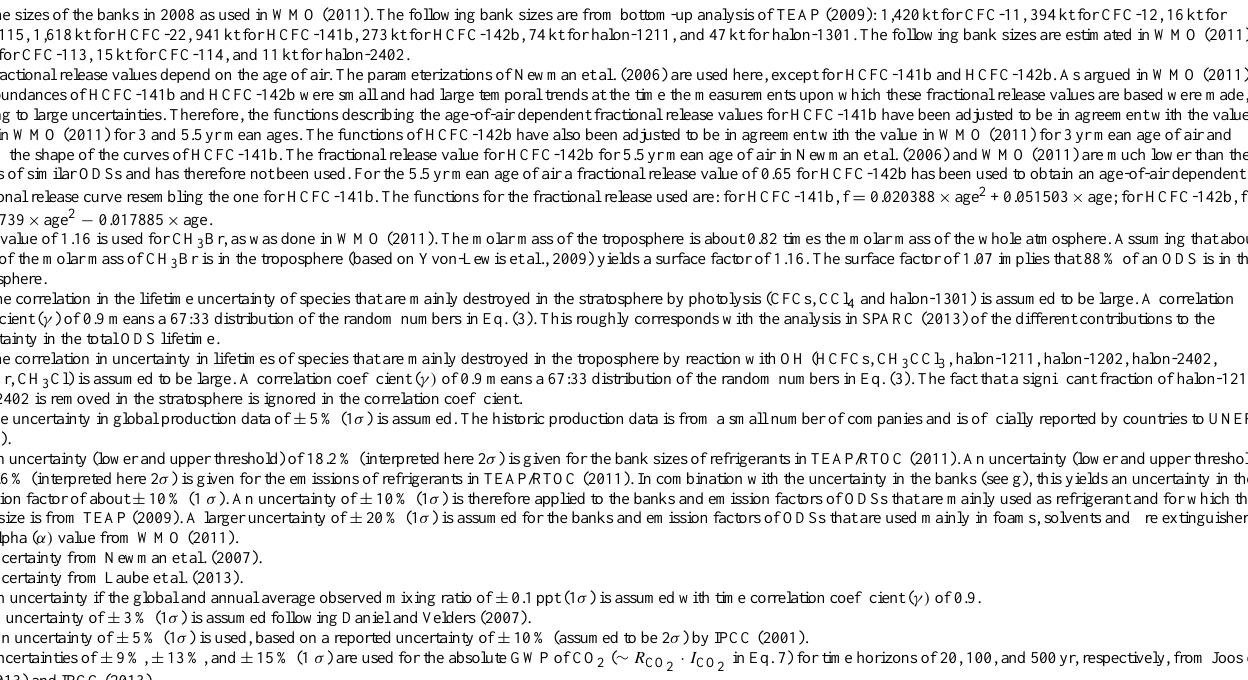
Table 2. Parameters and uncertainties used in the model calculations. Value Uncertainty (1 σ ) Note Lifetimes through oxygen photolysis see Table 1 see Table 1, γ = 0 . 9 (d) Lifetimes through OH abundance see Table 1 see Table 1, γ = 0 . 9 (e) Production data WMO (2011) ± 5% (f) Bank size of 2008 WMO (2011)(a) ± 10% for CFC-12, CFC-115, HCFC-22, ± 20% for other ODSs (g) Emission factor ( E f ) Calculated (g) (h, i) (h, i) 3.0yr (i) 5.5yr ± 0.3yr (i) Fractional release Newman et al. (2006)(b) ± 20% for HCFCs, ± 10% for other ODSs (j) Observed mixing ratios – ± 0.1ppt, γ =0.9 (k)